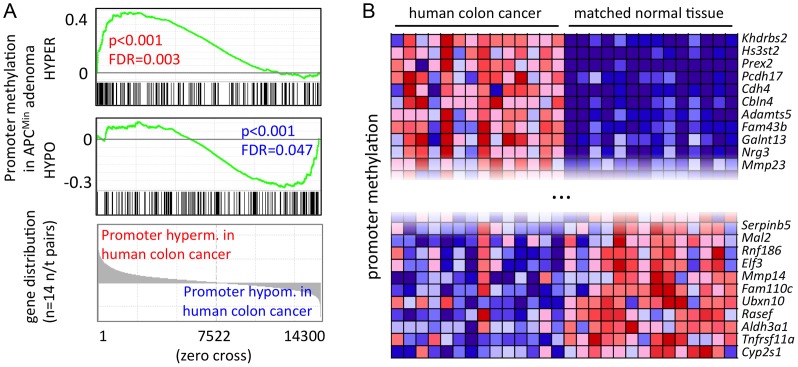
A core set of APCMin adenoma-specific CpG methylation patterns is conserved in human colon cancer.a) GSEA identifies methylation changes of mouse adenoma in human colon cancer. Gene signatures comprise genes with promoter hypo- or hypermethylation in mouse adenoma (see also Figure 4a, Table S5), genes were ordered by directional methylation changes in human colon cancer (normal tissue versus carcinoma). Mouse and human gene homologues were matched using ENSEMBL Biomart (approx. 14300 unique orthologue pairs were identified). b) Promoter hypo- and hypermethlyation is conserved between mouse APCMin adenoma and human colon cancer. Genes were selected from those that are significantly hyper- or hypomethylated in APCMin adenoma. Conserved genes were identified as the core enrichment group of GSEA analysis in a). Figure shows top eleven hypo- and hypermethylated genes in human colon cancer. blue: low relative methylation; red: high relative methylation.